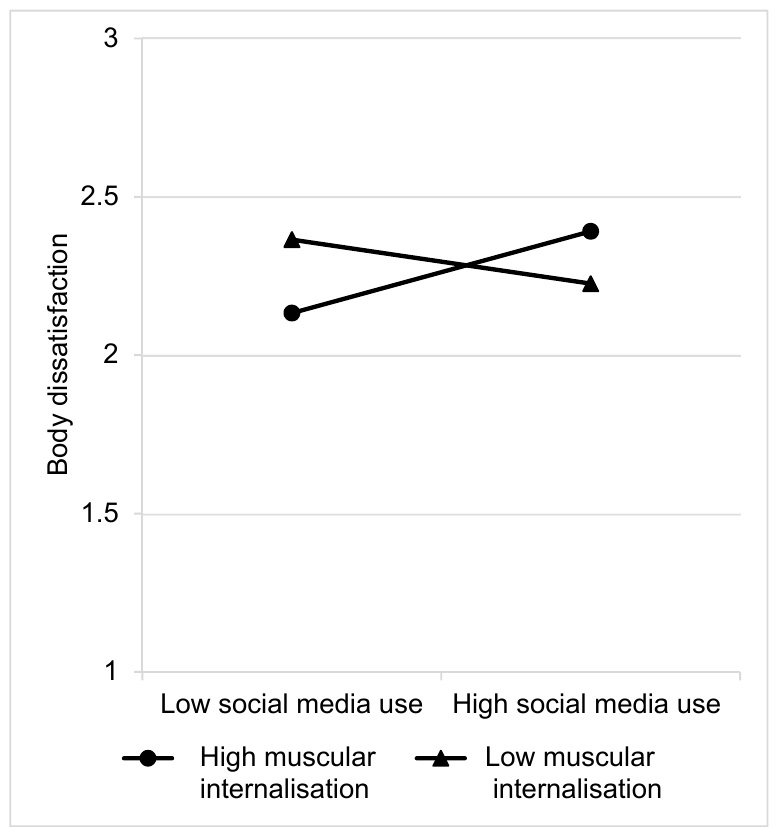
Figure 2. The two-way interaction effect of muscular-ideal internalisation and social media use on body dissatisfaction in boys.